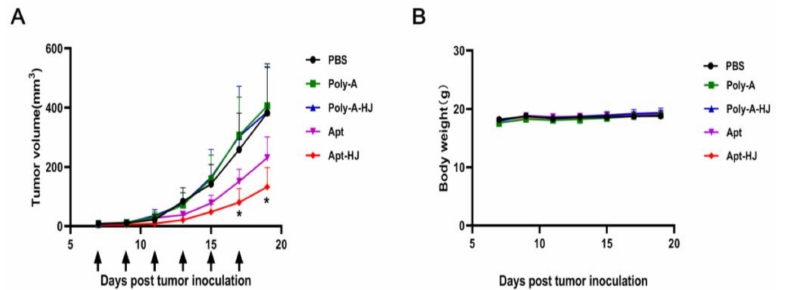
Figure 8. In vivo antitumor study with CT26-bearing BALB/c mice ( n = 7). CT26 tumor-bearing mice were treated with PBS, poly-A (control DNA sequence), poly-A-HJ, free PD-L1 aptamers, or Apt-HJ. The treatments were administered via intraperitoneal injection every two days, for a total of six injections (arrows). ( A ) Tumor volume and ( B ) body weights were recorded for various treatment groups. Stars indicate statistically significant differences ( p < 0.05) between the Apt and the Apt-HJ groups, with p values of 0.011 and 0.020, respectively (raw data are presented in Table